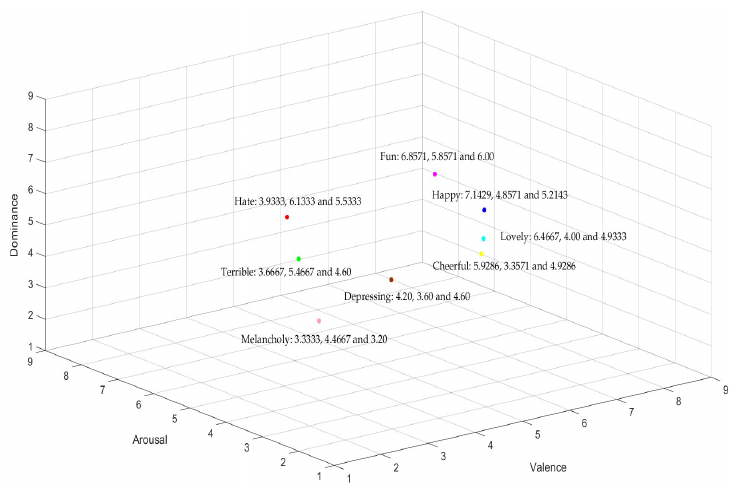
Figure 1. Three-dimensional space of the emotion model.